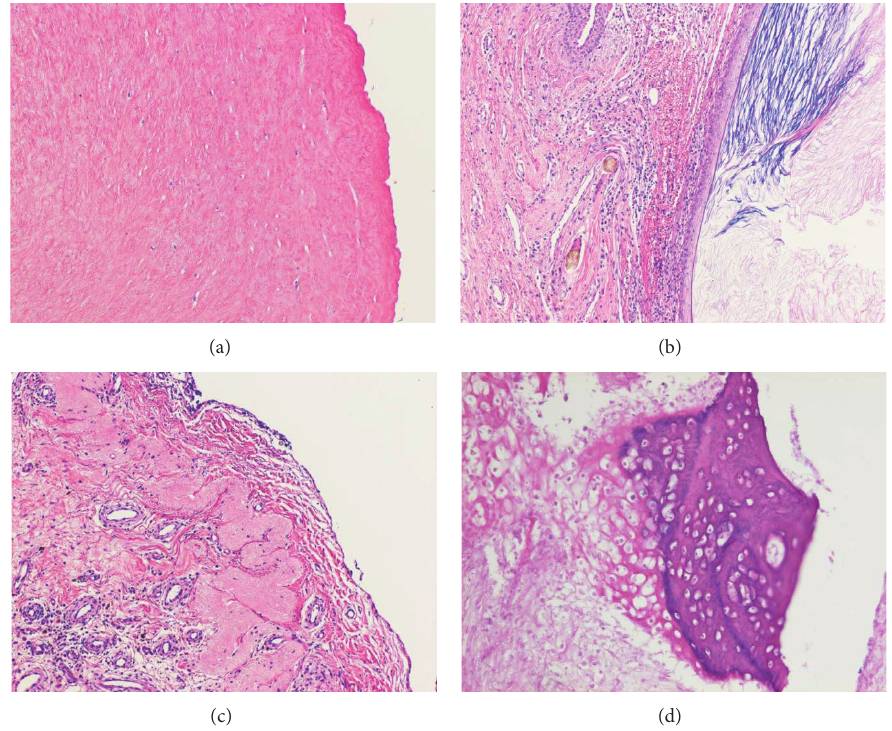
Figure 4: Microscopic findings of the tumor: (a) the tumor showed hyalinization. The main components of the tumor were (b) cysts and hair, (c) neural tissue, and (d) cartilage. (Hematoxylin and Eosin staining, original magnification × 4 (a, b, c), × 10